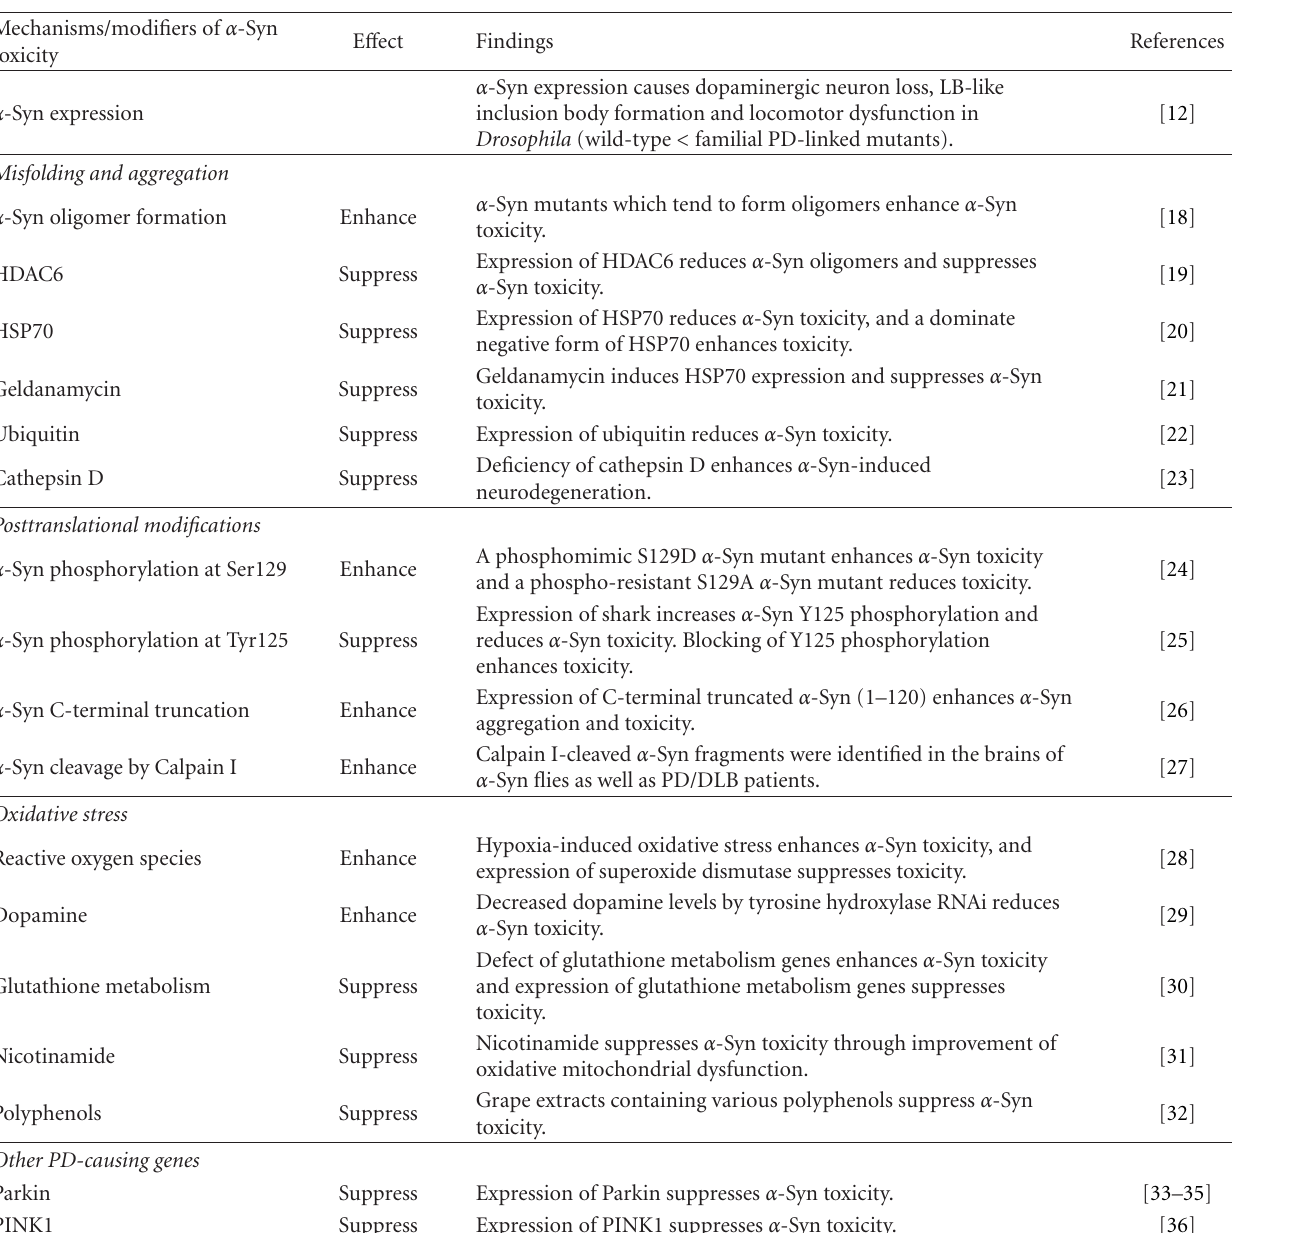
Table 2: Summary of studies on α -Syn-induced neurodegeneration using Drosophila